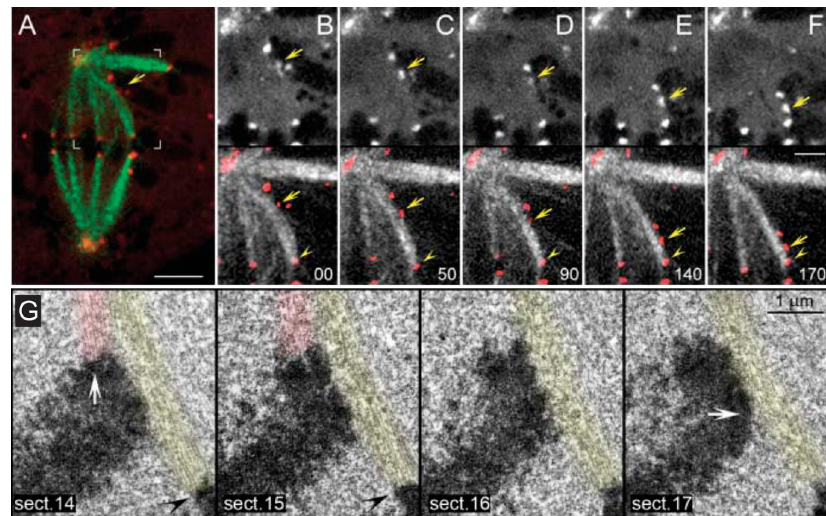
Figure 5. Demonstration that chromosome congression is independent of bi-orientation. From A-F, the movement of a polar chromosome along a pre-existing k-fiber is illustrated in a PtK1 cell. The leading kinetochore is indicated (yellow arrows). The kinetochore of a neighbor k-fiber on a bi-oriented chromosome is also indicated (yellow arrowheads). Time is in sec. In G, serial sections of a sliding mono-oriented chromosome with the leading kinetochore laterally attached to a neighbor k-fiber. Kinetochores of the congressing chromosome are indicated (white arrows), as well as the kinetochore of a neighbor k-fiber (black arrowheads). Images adapted from Kapoor et al., 2006 [300]. Reprinted with permission from The American Association for the Advancement of Science (AAAS).